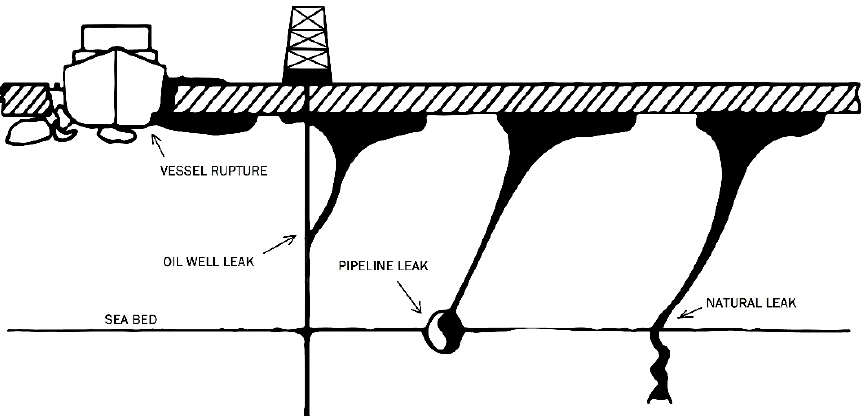
Figure 1. Potential sources of subsurface oil: vessel rupture; oil well leak; pipeline leak; natural leak (created by authors).